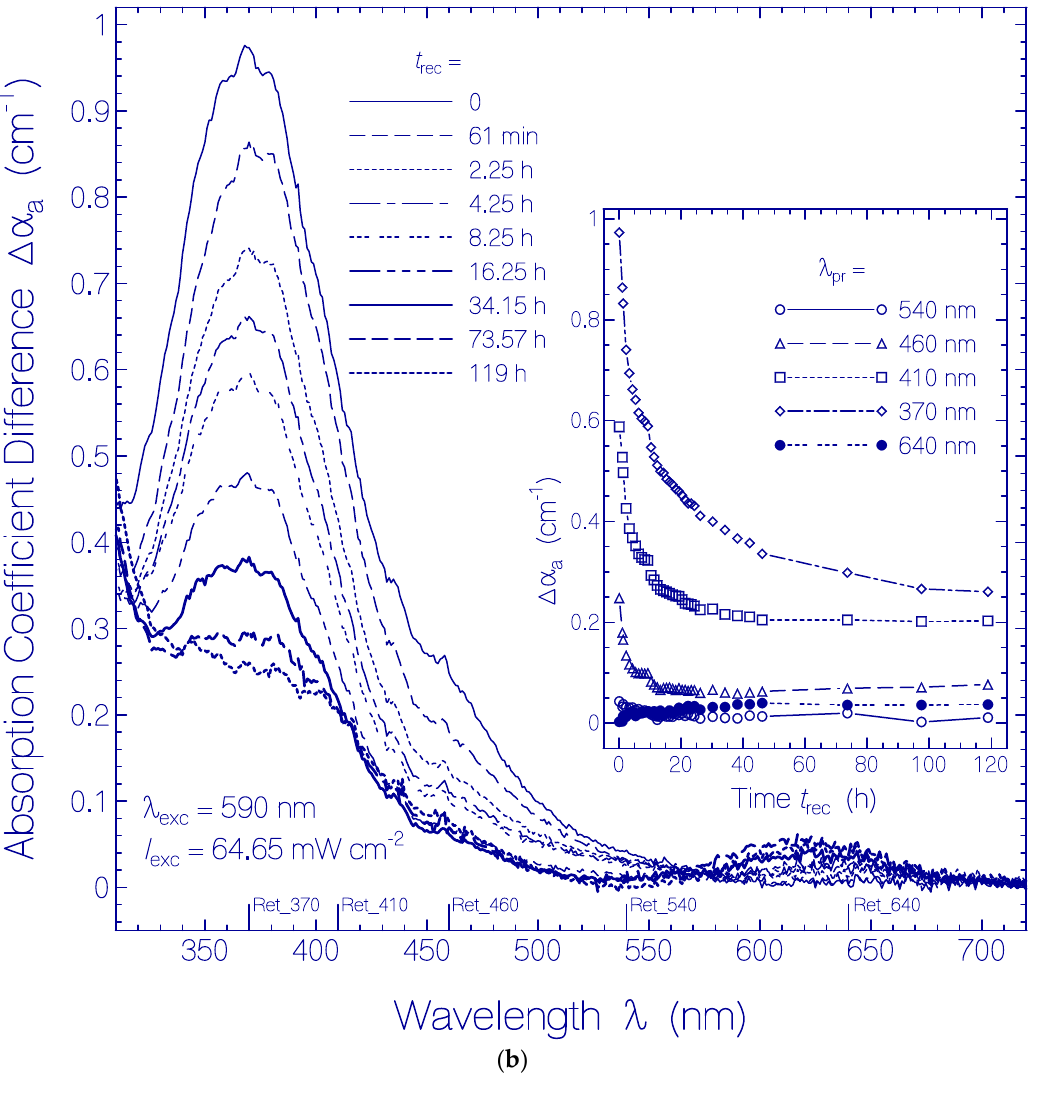
Figure 3. ( a ) Absorption coefficient spectra recovery of QuasAr1 in pH 8 Tris buffer after light exposure with LED 590 nm (input excitation intensity I exc = 64.65 mW cm − 2 ) for an exposure time of t exc = 25 min (see Figure 1a). Immediately after the end of exposure, fluorescence emission spectra were measured. The durations of recovery t rec are listed in the figure. The absorption coefficient spectra before exposure ( t exc = 0) and at the end of exposure ( t exc = 25 min) are included. The inset shows the absorption coefficient recoveries α a ( t rec ) at λ pr = 580 nm and 370 nm. The data points are fitted by α a ( t rec ) = α a ( 0 ) + ∆ α I [ 1 − exp ( − t rec / τ rec , I )] + ∆ α II [ 1 − exp ( − t rec / τ rec , II )] with α a (0,580 nm) = 0.22 cm − 1 , ∆ α I (580 nm) = 0.71 cm − 1 , τ rec,I (580 nm) = 1.52 h, ∆ α II (580 nm) = 0.376 cm − 1 , τ rec,II (580 nm) = 19.26 h, α a (0,370 nm) = 1.15 cm − 1 , Δα I (370 nm) = − 0.195 cm − 1 , τ rec,I (370 nm) = 2.96 h, Δα II (370 nm) = − 0.358 cm − 1 , and τ rec,II (370 nm) = 26.7 h. ( b ) Absorption coefficient difference spectra development ∆ α a ( λ , t rec ) = α a ( λ , t rec ) − α a ,Ret_580 ( λ , t rec ) − α a ,Residuals ( λ , t exc = 0 ) of QuasAr1 in pH 8 Tris bu ff er after light exposure with LED 590 nm of input intensity I exc = 64.65 mW cm − 2 for 25 min. The inset shows the temporal development of ∆ α a at λ pr = 640 nm, 540 nm, 460 nm, 410 nm, and 370 nm versus recovery time t rec .